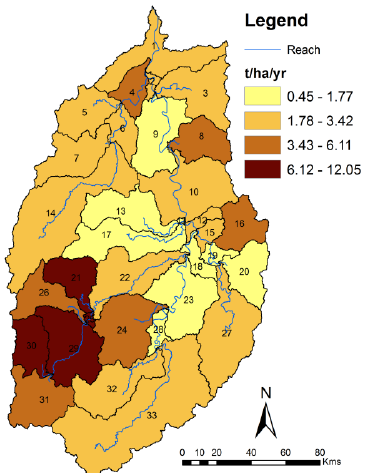
Figure 3. Soil loss rate map of the basin under the base